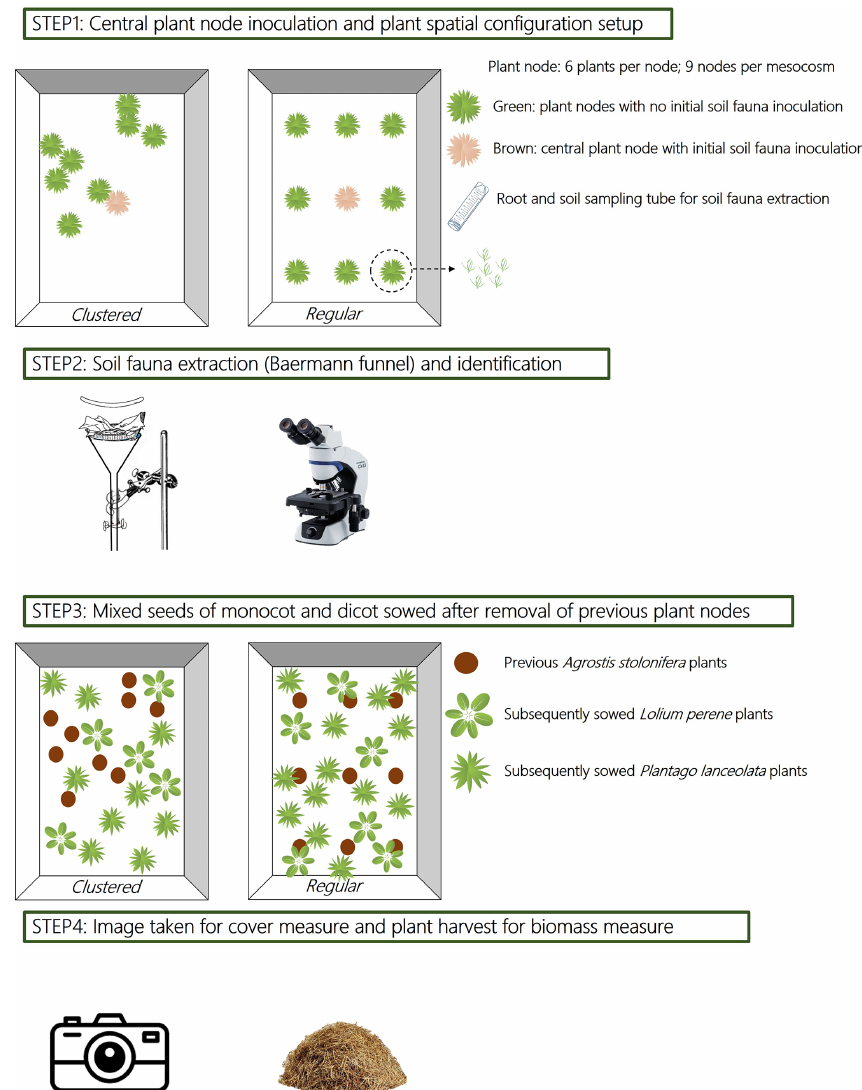
Figure 1. Schematic diagram of the experiment on soil fauna dispersal and the experiment on legacy effects. Step 1 shows two mesocosms (one clustered and one regular plant spatial configuration) with nine plant nodes (each node consists of six Agrostis stolonifera plants, see inset figure), the central node was firstly inoculated with soil fauna before adding it into the mesocosm. Step 2 indicates that one A. stolonifera plant was sampled from each plant node every 15d for soil fauna extraction from the roots and rhizosphere soil using Baermann funnels. The collected soil fauna were counted under the microscope. Step 3 shows two mesocosms (one clustered and one regular plant spatial configuration) which were sowed with new seeds of Lolium perenne and Plantago lanceolata after the removal of previous A. stolonifera plants from the soil fauna dispersal experiment. Step 4 illustrates that photographs were taken from the mesocosms shown in step 1 once a week, starting after 2 weeks of seed germination for a total of 7 weeks. The aboveground biomass of L. perenne and P. lanceolata was harvested after 9 weeks of growing, and dried for biomass measurement. The photographs were then analysed using an image analysing package in R to assess plant